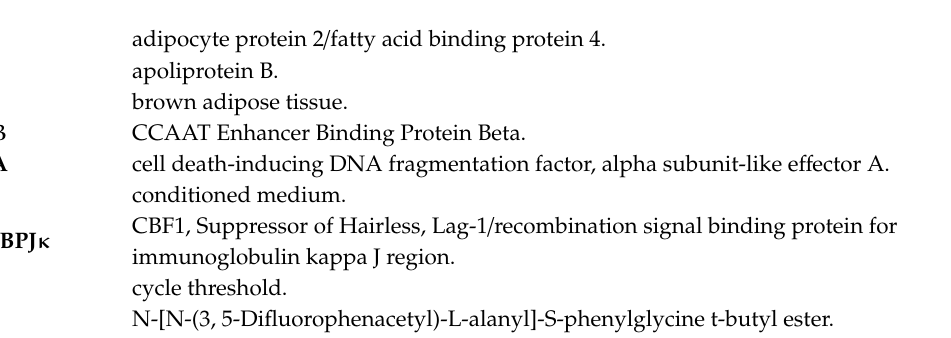
s1. Figure S1: Comparison of adipogenesis levels and expression levels of some of the Notch family genes between multipotent C3H10T1 / 2 cells and 3T3-L1 preadipocytes . Figure S2: Stable overexpression of NOTCH receptors in mesenchymal C3H10T1 / 2 cells. Figure S3: Overexpression of DLK proteins and NOTCH activation and